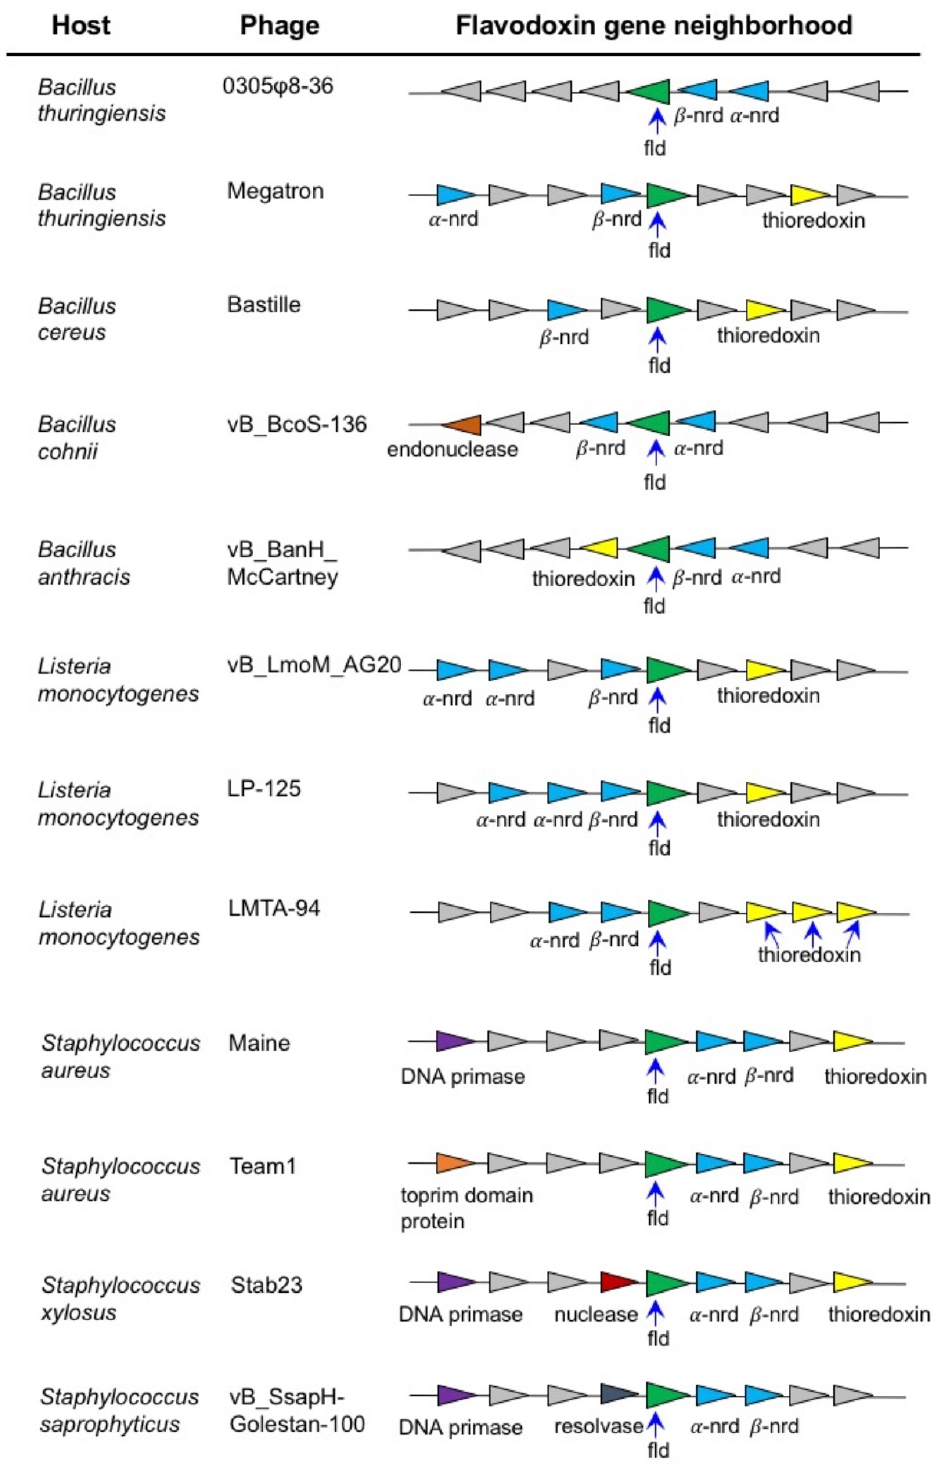
Figure 6. Microsynteny around phage flavodoxin genes. Comparison of the genetic loci and surrounding genes for flavodoxins in Bacillus phages, Listeria phages and Staphylococcus phages. Each phage flavodoxin gene (fld) is colored green and α and β ribonucleotide reductase genes ( α and β nrb)